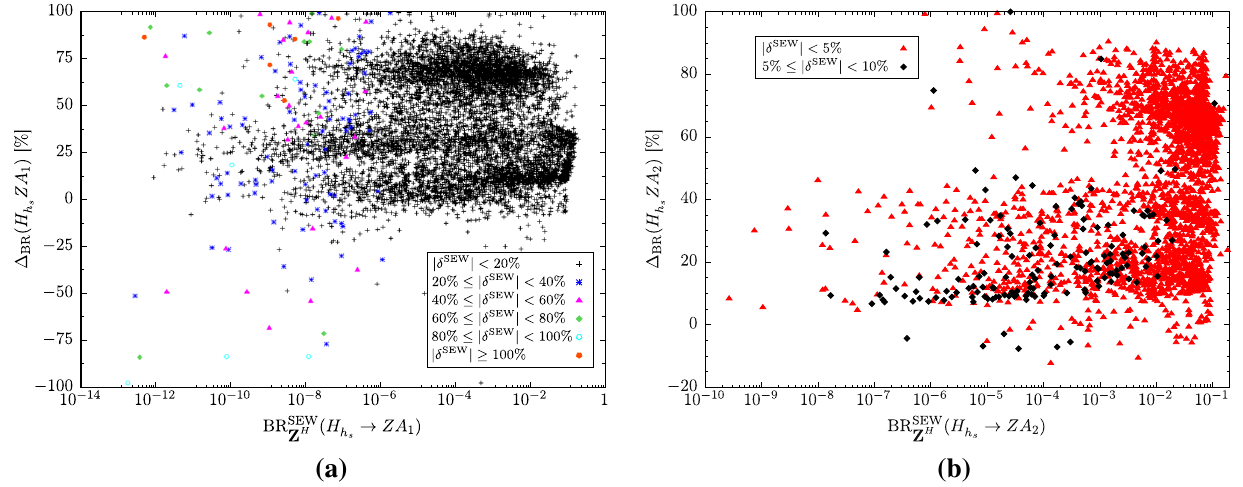
Fig. 8 Scan2:Relativedifference (cid:20) BR inpercentforthe H a -likeHiggs bosondecayinto Z H 1 (left)andinto Z H 2 (right)asafunctionofthecor- responding loop-corrected branching ratio. Black: relative corrections δ SEW in percent of the SUSY-EW corrections to the decay widths with